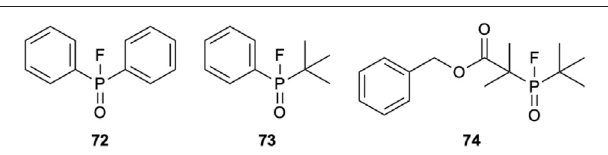
FIGURE 10 | 72 – 74 have been radiolabeled through 19 F/ 18 F isotopic exchange. 74 offers the greatest hydrolytic stability and can be radiolabeled in